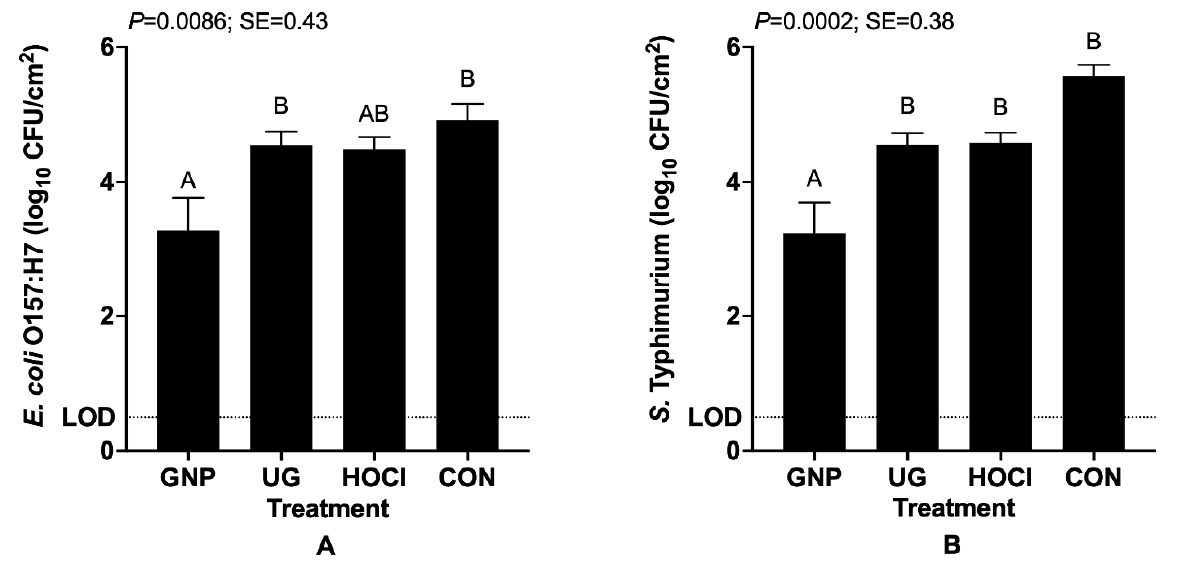
Figure 2. Least squares means of surviving numbers of E. coli O157:H7 ( A ) and Salmonella typhimurium ( B ) on tomato skin samples when inoculated with pathogens before and after sanitization treatment. Treatments are GNP (0.5 wt.% geraniol in polymeric nanoparticles), UG (0.5 wt.% unencapsulated geraniol in sterile distilled water), HOCl (200 mg/L pH 7.0 hypochlorous acid), CON (sterile distilled water). Bars represent means of triplicate identical replicates ( n = 3); error bars depict the standard error of means. SE: pooled standard error. Bars not sharing a capitalized letter (A, B) differ at p = 0.05 by one-way analysis of variance and Tukey’s Honestly Significant Differences test.